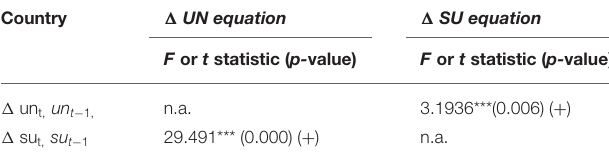
TABLE 4 | Granger-causality analysis based on bootstrap ARDL